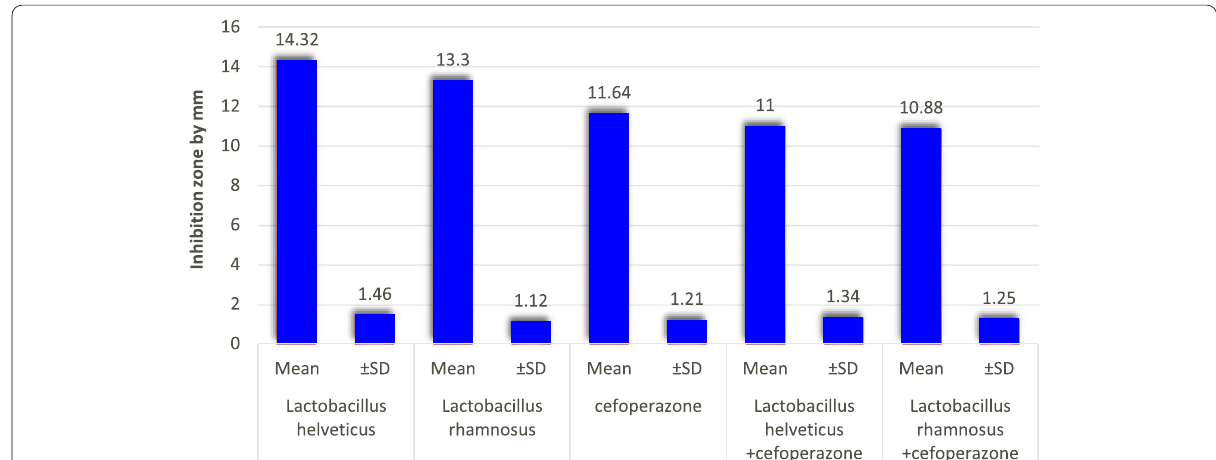
Fig. 2 Antimicrobial effect of Lactobacillus helveticu s and Lactobacillus rhamnosus versus the minimal inhibitory concentration of cefoperazone (512 μg/ml) alone and in combination with each of